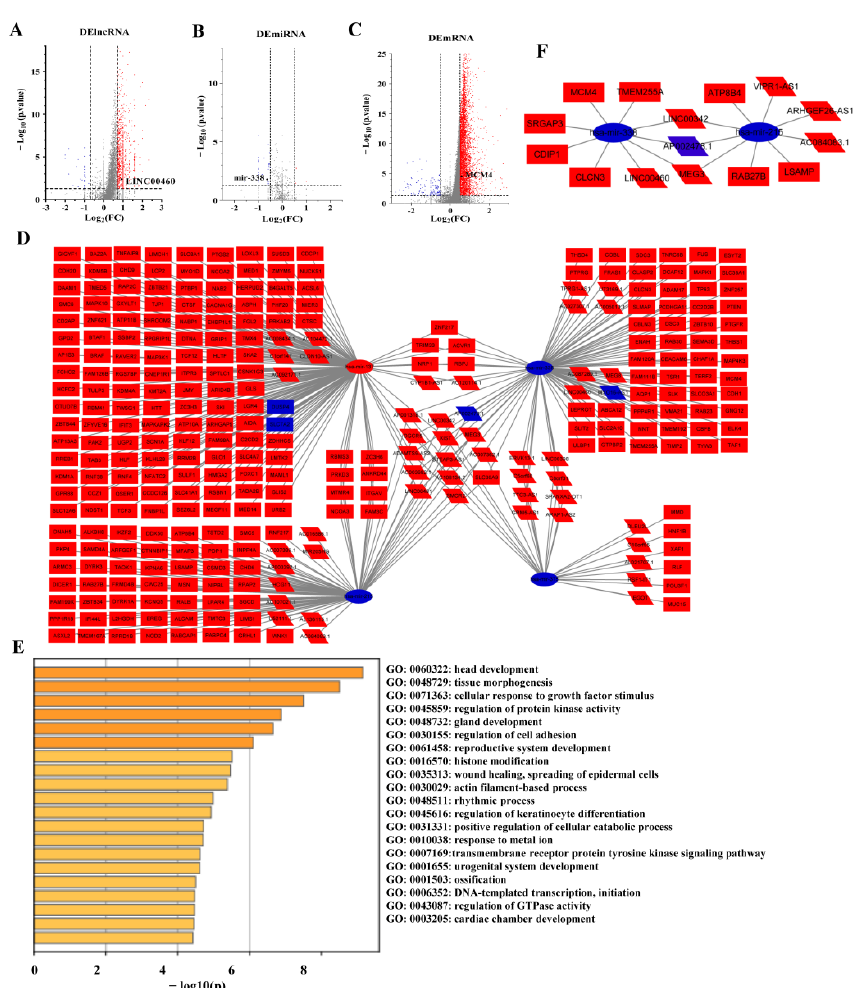
Figure 2. Volcano map of DERNAs between EGFR high and EGFR low expression in LUAD samples and construction of ceRNA network. Red indicates upregulation, blue represents downregulation. ( A ) Volcano plots of differentially expressed lncRNAs (DElncRNA) (|log 2 FC| > 0.70, p < 0.05). ( B ) Volcano plots of differentially expressed miRNAs (DEmiRNA) (|log 2 FC| > 0.50, p < 0.05). ( C ) Volcano plots of differentially expressed mRNAs (DEmRNA) (|log 2 FC| > 0.50, p < 0.05). ( D ) The triple regulatory network in LUAD. ( E ) Functional enrichment analysis of mRNAs in the network. (F) Survival-related DERNAs regulatory network in LUAD.